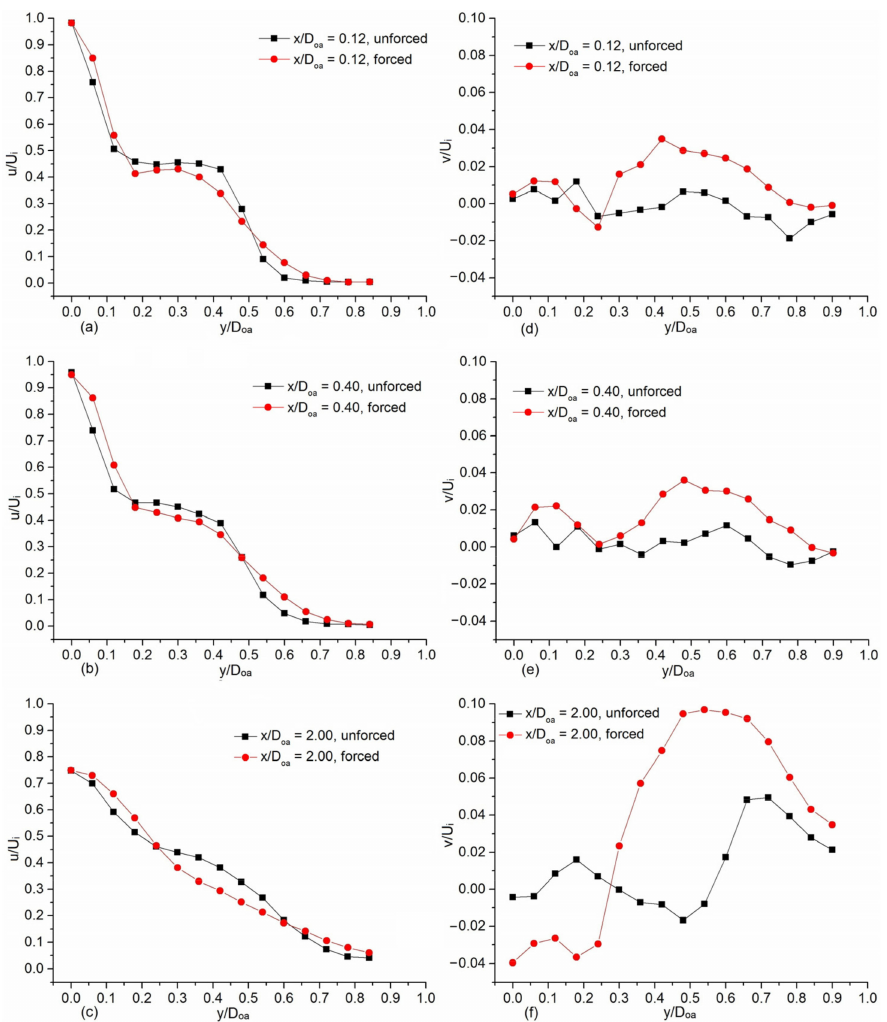
Figure 4. The radial distribution of time averaged streamwise velocity ( a – c ) and radial velocity ( d – f ) at different axial positions of nozzle